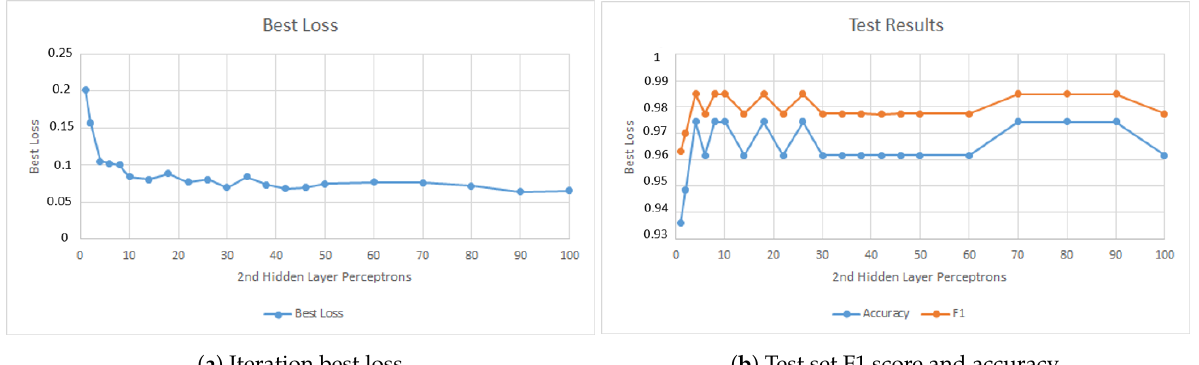
Figure 9. Model performance behavior when changing the number of perceptrons in the second hidden layer.